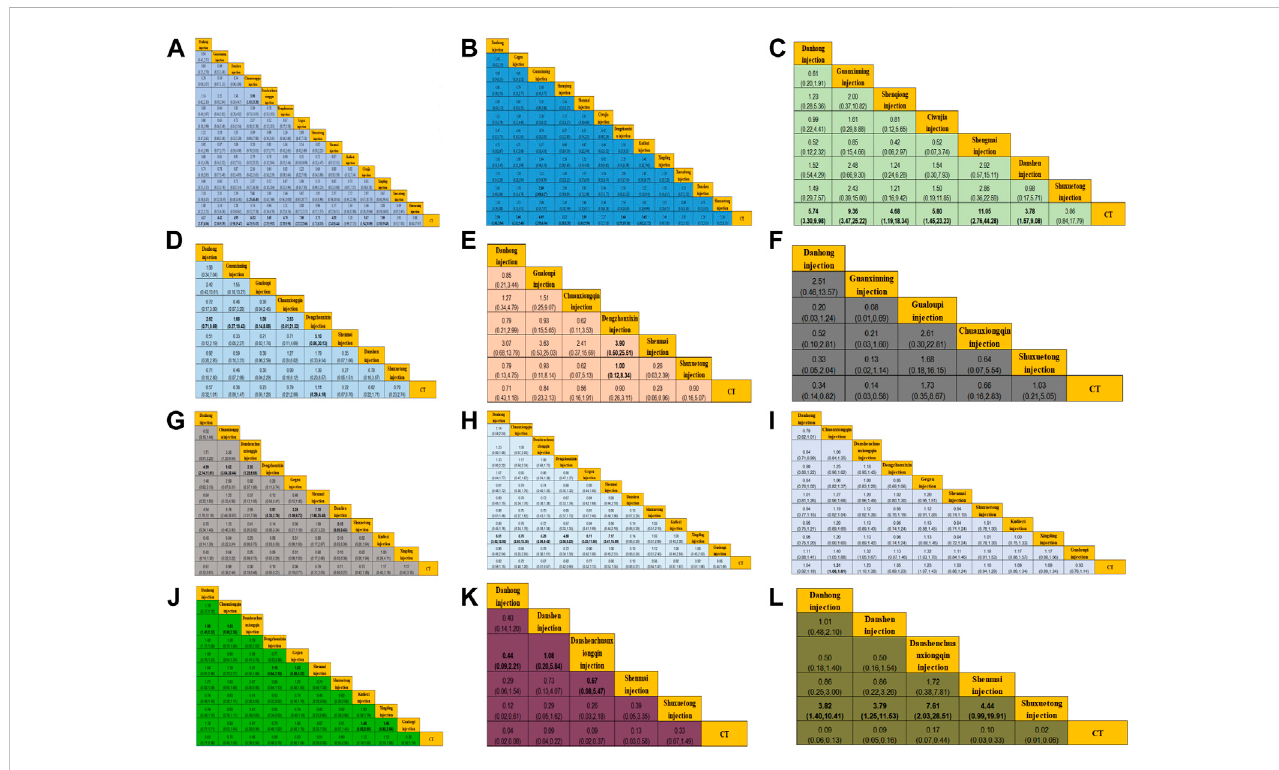
FIGURE 4 Final results of the systematic meta − analysis. (A) Total effective rate; (B) EGG effective rate; (C) Effective rate of angina pectoris; (D) FBG; (E) PBG; (F) HbA1c; (G) TC; (H) TG; (I) HDL; (J) LDL; (K) Frequency of angina pectoris; (L) Duration of angina pectoris.